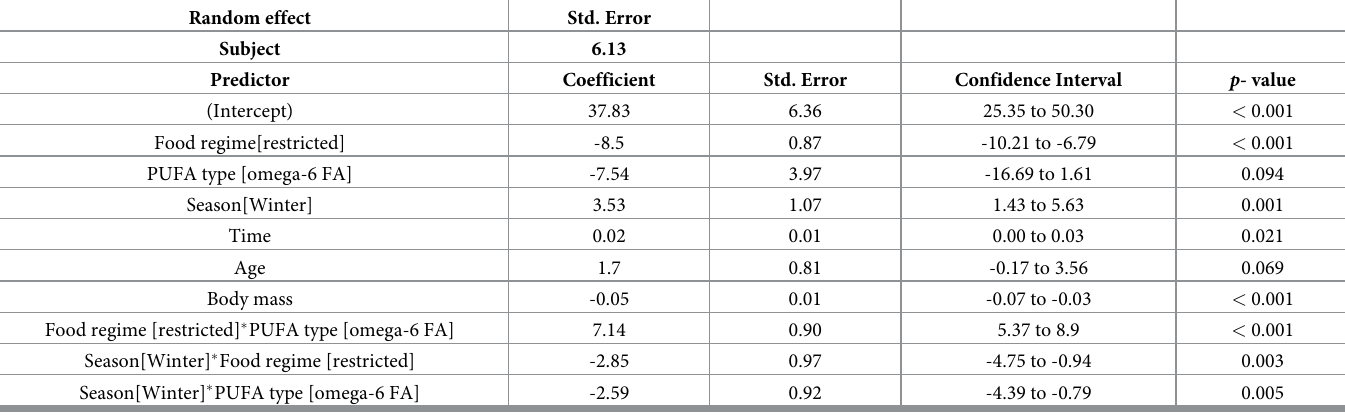
Table 1. Factors explaining the variation in heart rate of anaesthetised female red deer. Results of the best fitted linear mixed effect model explaining f H of female red deer ( Cervus elaphus , n = 11) during anaesthesia with 0.1 mg/kg medetomidine and 3 mg/kg tiletamine-zolazepam. Animals were anaesthetised twice in winter ( ad libitum and restricted feed) and twice in summer ( ad libitum and restricted feed) and received pellets enriched with omega-3 FA (n = 5) or omega-6 FA (n = 6) (type of PUFA supplementation). Random effect Std.